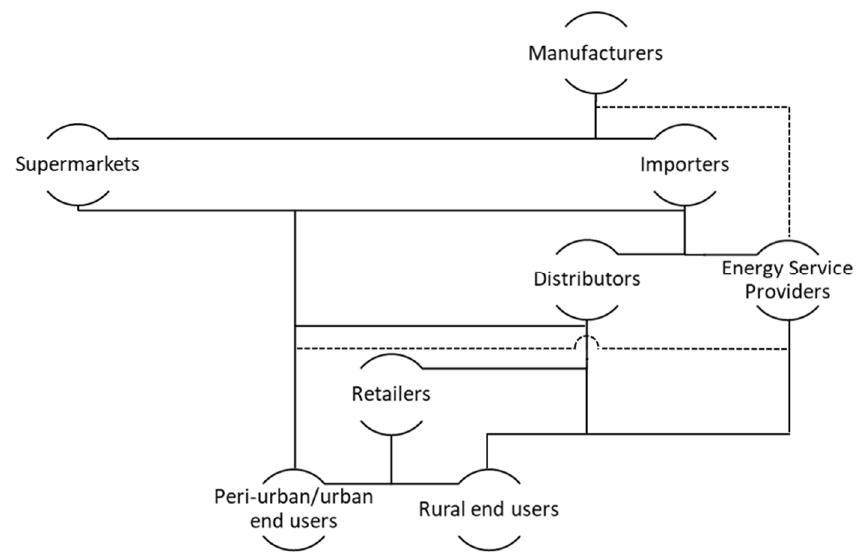
Figure 4. A map of the market chains that could be used to reach end-user groups. Solid lines represent those that already exist (though are nascent) and dashed lines indicate connections that could exist, but which are not currently known to be operational in Tanzania for EPCs.